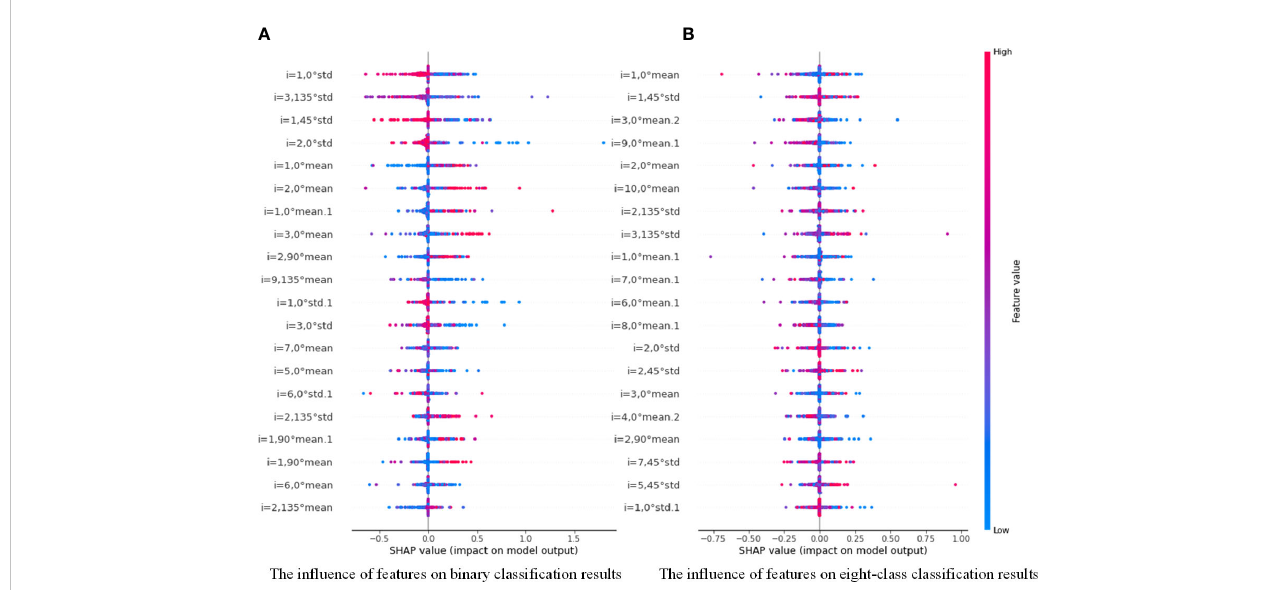
FIGURE 10 Distribution of the in fl uence of different features on PGLCM-SARF model.0 (A) The in fl uence of features on binary classi fi cation results; (B) The in fl uence of features on eight-class classi fi cation